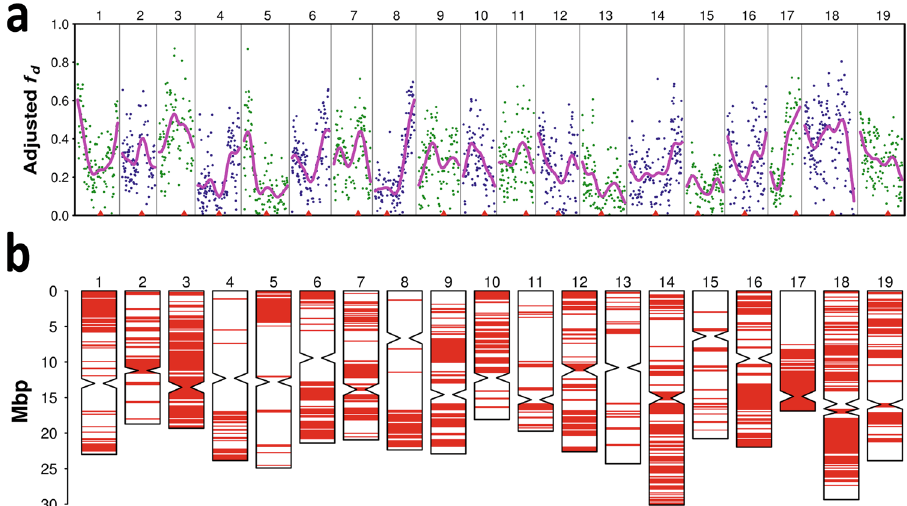
Fig. 2 Chromosomal patterns of gene fl ow from western sylvestris into table grapes generating Alpine wine grapes. a Dots represent adjusted f d values in 100 Kb windows of non-repetitive DNA. Lines represent cubic smoothing splines of the values. b Diagram of 100 Kb chromosomal windows (in red) that show phylogenetic tree topologies with shorter genetic distance between Alpine wine grapes and western sylvestris than between Alpine wine grapes and any other cultivated group. Red triangles in a and constricted regions in b indicate the location of centromeric repeats. Source data are provided as a Source Data fi